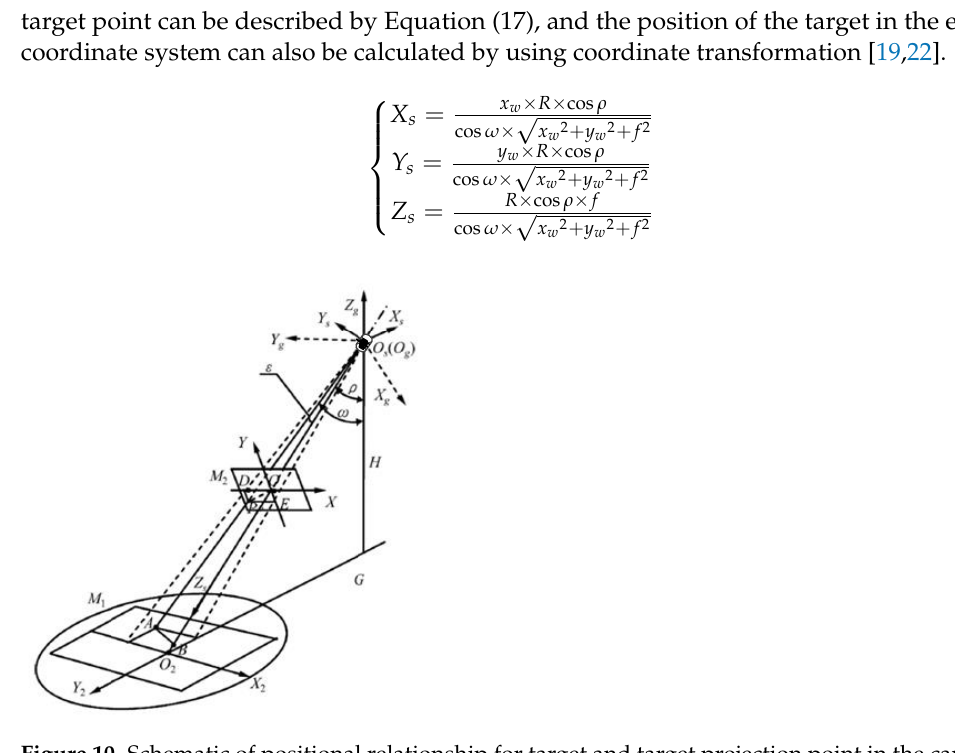
Figure 10. Schematic of positional relationship for target and target projection point in the camera coordinate frame.